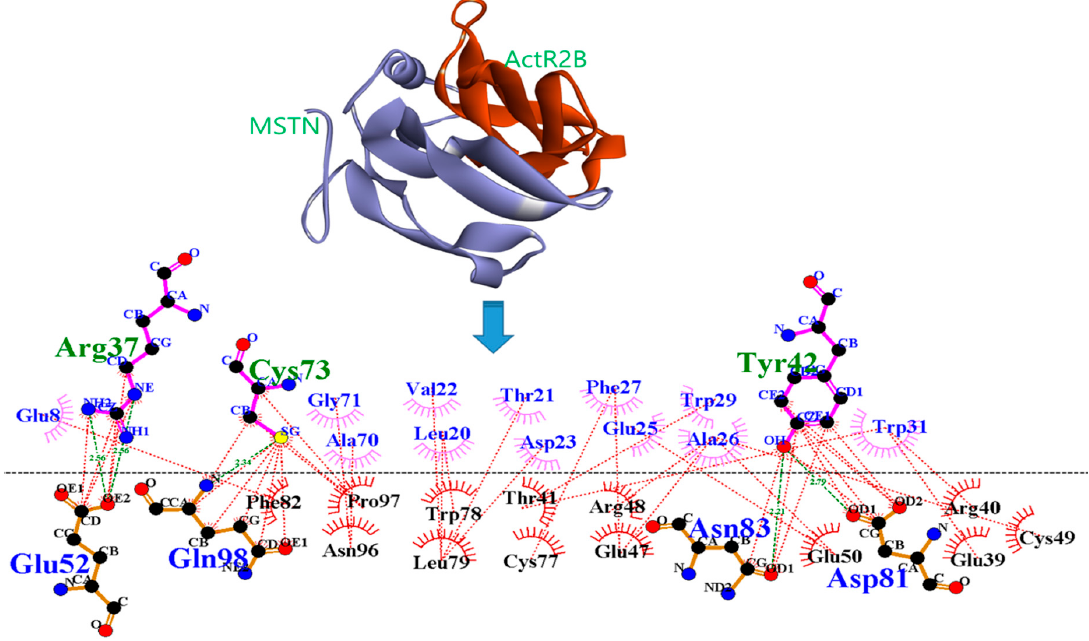
Figure 5. PPI diagram for MSTN and ActR2B. Green dotted lines indicate an H-Bond and brown dotted lines indicate hydrophobic interactions.